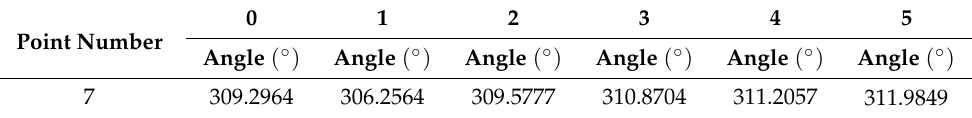
Table 2. Results of reading the values of angles by applying 2D deflection sensor.